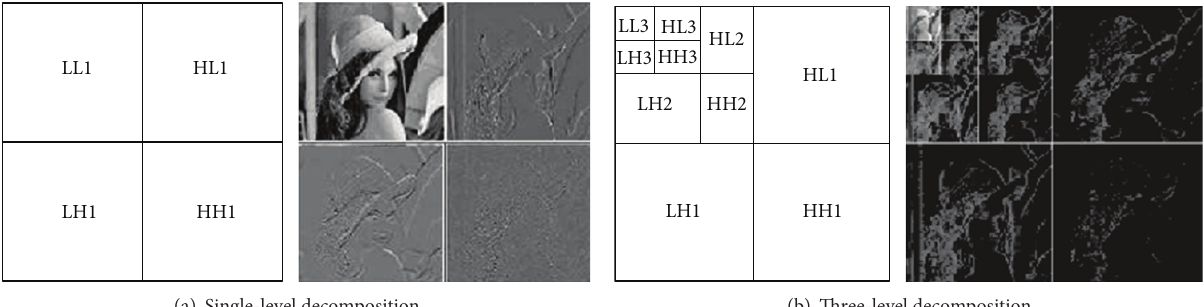
Figure 2: One- and three-level DWT decomposition of Lena